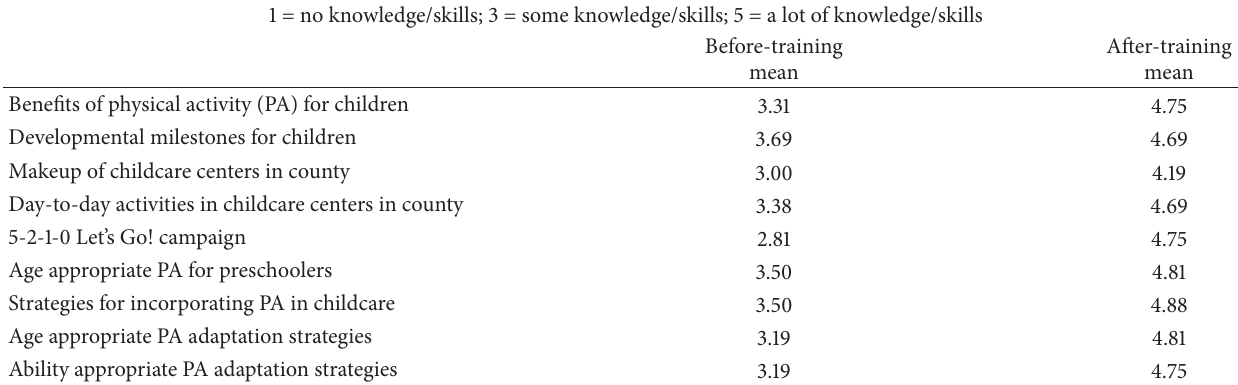
Table 5: Self-assessment of knowledge and